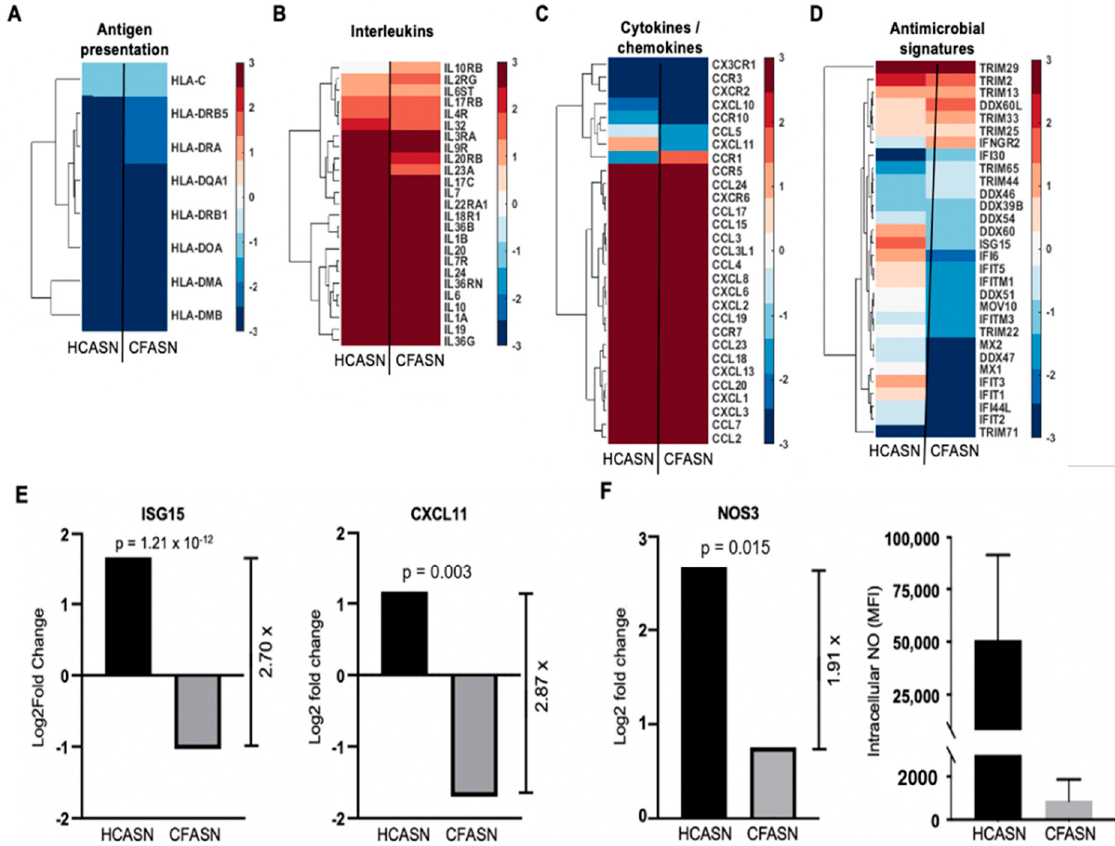
Figure 6. Analysis of differentially expressed genes (DEGs) related to immunity in monocytes transmigrated to HCASN vs. CFASN. Shown are chosen DEGs representative of ( A ) antigen presentation, ( B ) interleukins, ( C ) cytokines/chemokines, and ( D ) antimicrobial signatures. Shown in ( E ) are ISG15 and CXCL11, two genes with direct antibacterial functions, which are significantly downregulated in CFASN-recruited monocytes (Log2 scale for both), and in ( F ) the nitric oxide producing enzyme NOS3 (left panel, Log2 scale) and corresponding intracellular NO levels (right panel, shown as MFI).